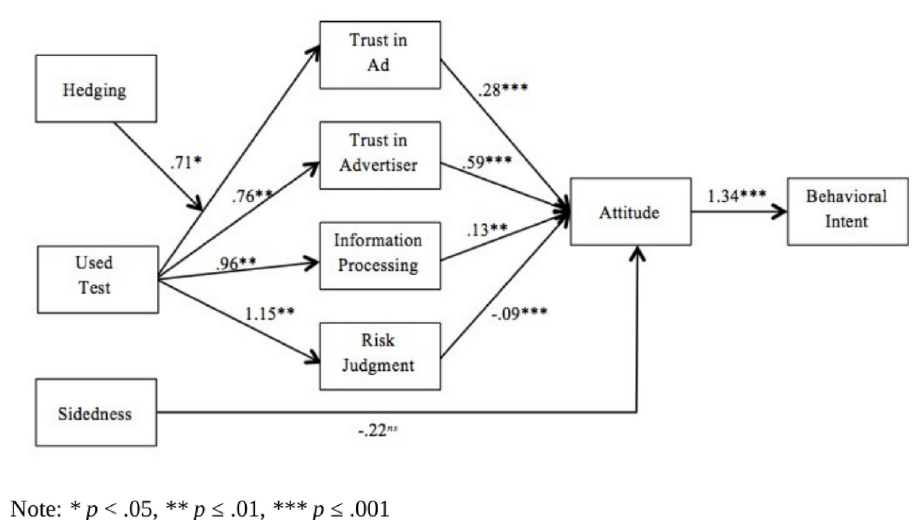
Fig 2. Analyzed path model omitting most non-significant paths to reduce visual